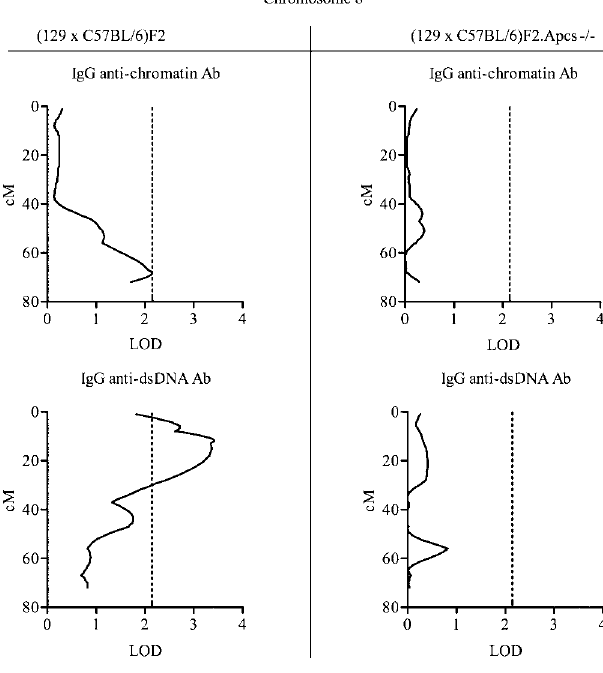
Figure 2. Linkage of Chromosome 8 with Anti-Chromatin and Anti- dsDNA Abs in (129 3 C57BL/6)F2 Mice These linkages were not detected in (129 3 C57BL/6)F2 .Apcs (cid:1) / (cid:1) animals. Centimorgan positions were deduced by interval mapping, anchoring marker locations to data from http://www.informatics.jax. org. Dotted lines indicate the threshold over which linkage was considered suggestive, as defined in Materials and Methods. DOI: 10.1371/journal.pbio.0020243.g002